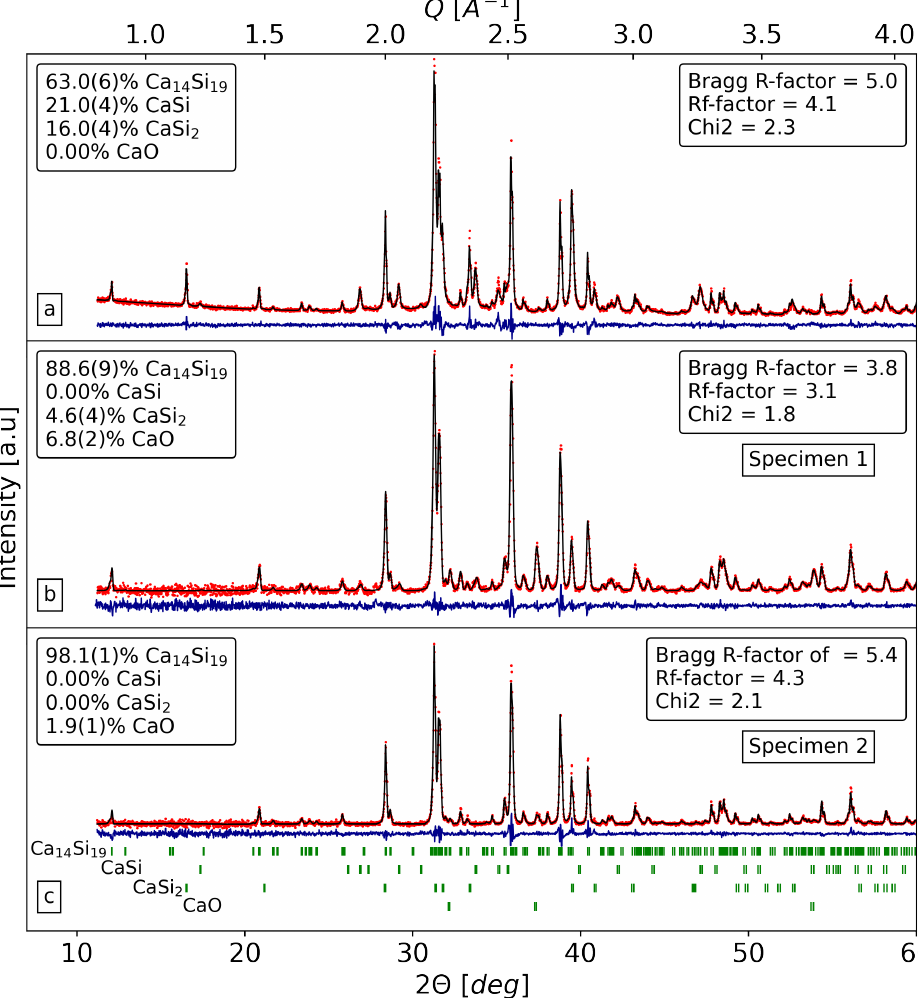
Figure 1. X-ray diffraction and Rietveld refinement results for specimens after arc melting ( a ), after RSPS for specimen 1 giving a weight percentage of ∼ 89% of Ca 14 Si 19 ( b ), and for specimen 2 giving the weight percentage of ∼ 98% of Ca 14 Si 19 ( c ). The figure shows the X-ray data (red points), Rietveld profile (black solid lines), the difference between both (dark blue lines), and the Bragg peak positions for the phases identified in the specimens (green tick marks). The relative compositions of the specimens and the fit quality factors (Bragg R-factor and RF-factor are for the Ca 14 Si 19 ; Chi2 factor for the entire refinement) are shown to the left and right,